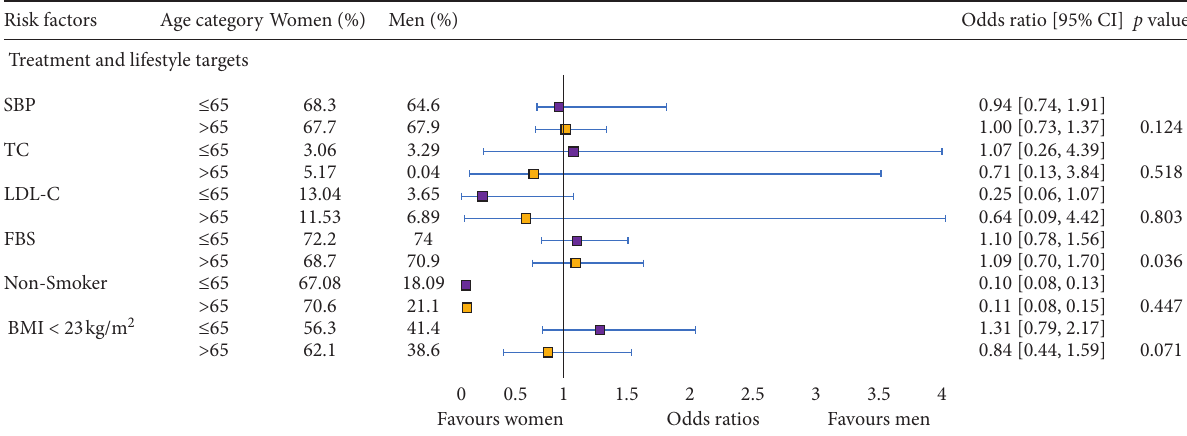
Figure 3: Age-adjusted sex differences in lifestyle factor management, stratified by age